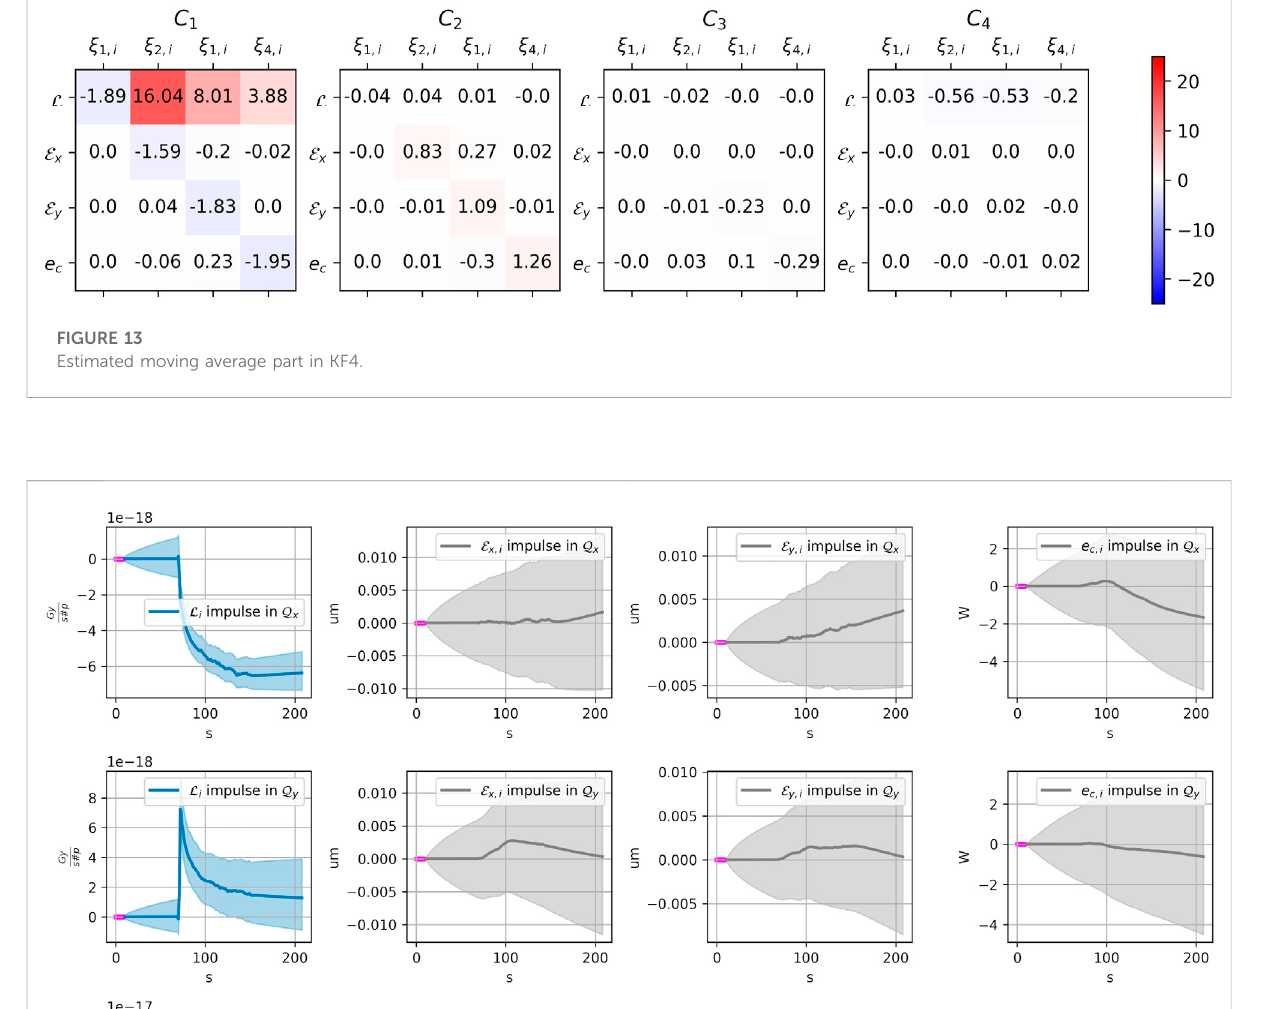
2017, where 8A outlines the quality of forecasts on the training dataset, and 8B shows the quality of forecasts on the testing dataset of 2018. For the models (KF1), (KF1*) with 1D outputs, the results show that they were capable of predicting losses of the other year only on short horizons. Inclusion of additional non-